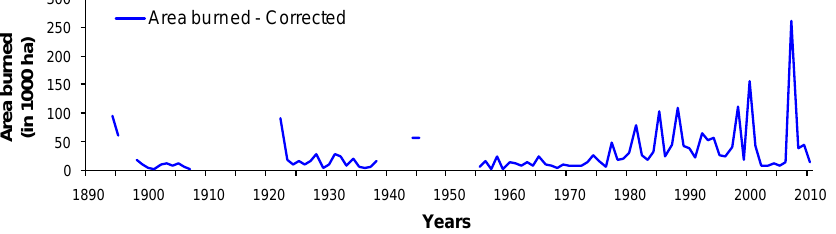
Fig. 1. Historical time series of area burned in Greece from 1894 to 2010. Area burned is corrected on the basis of country’s surface as described in the methods